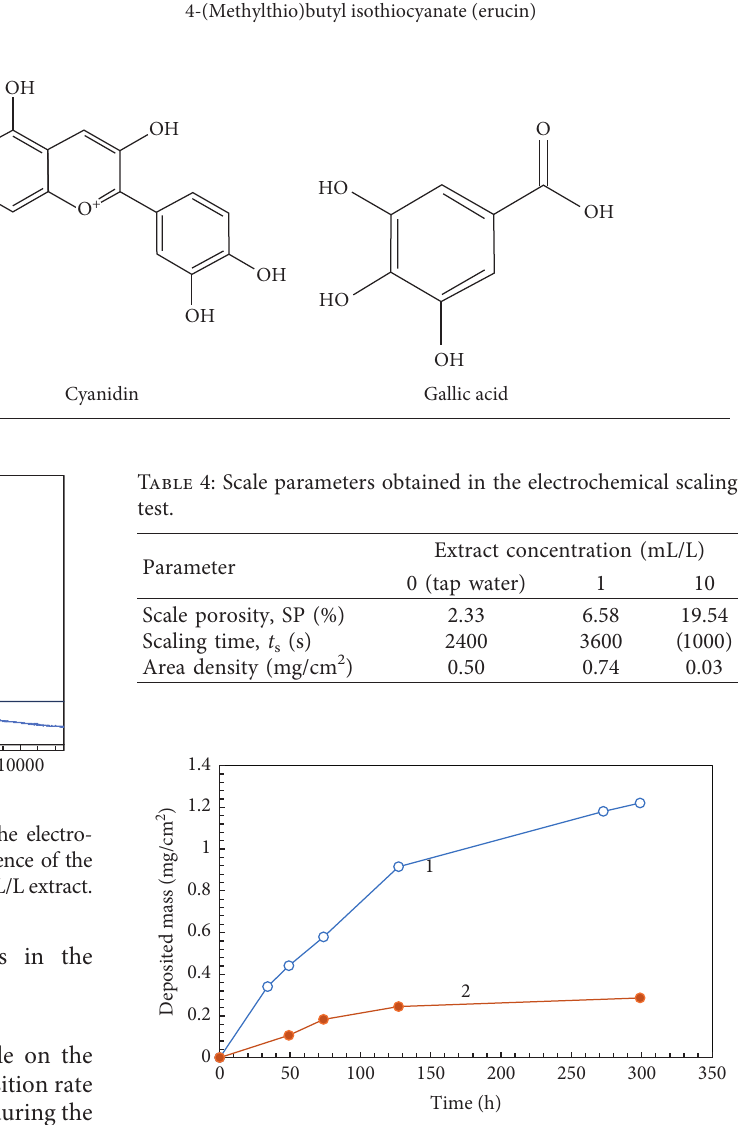
Figure 3: Scaling rate of mild steel in tap water at 100 ° C:1, blank; 2, with 10 mL/L of radish cake extract.